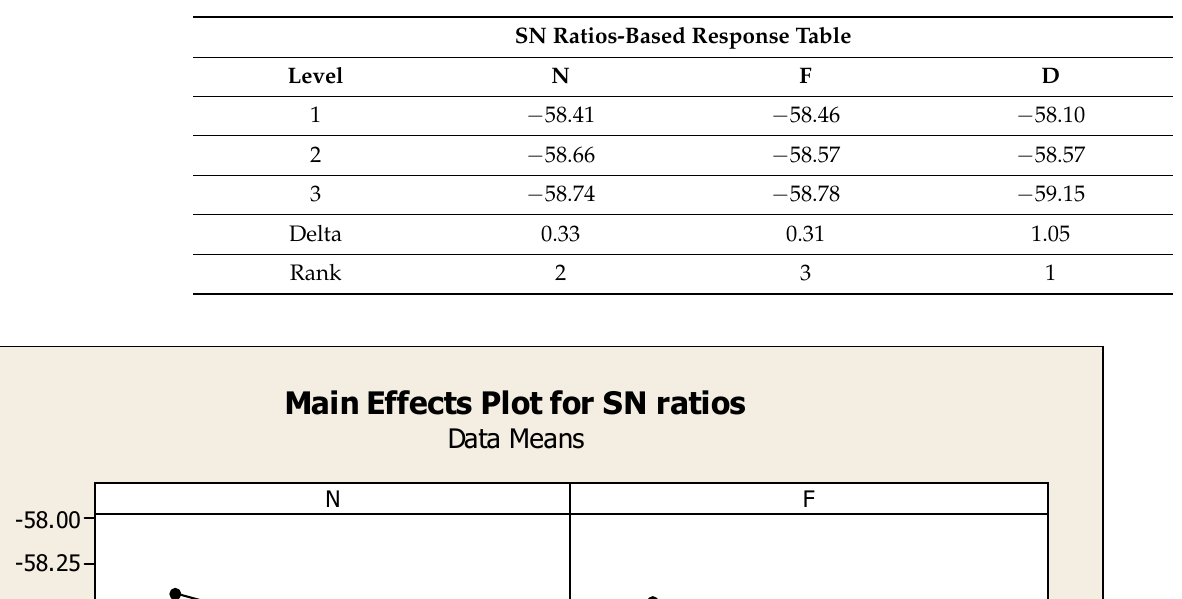
Table 6. Taguchi investigation details of CF vs. N, F, and D.